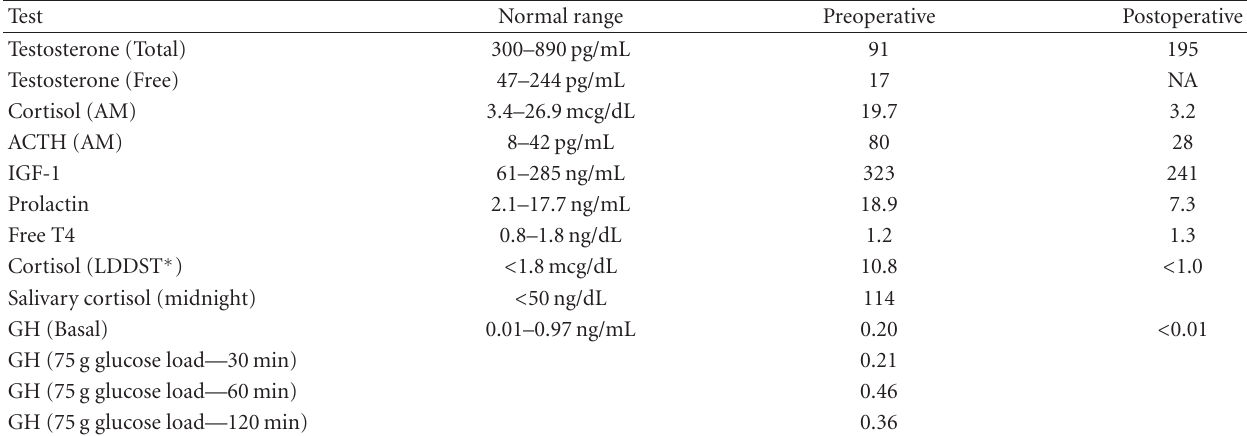
Table 1: Hormonal profile pre- and postoperatively.